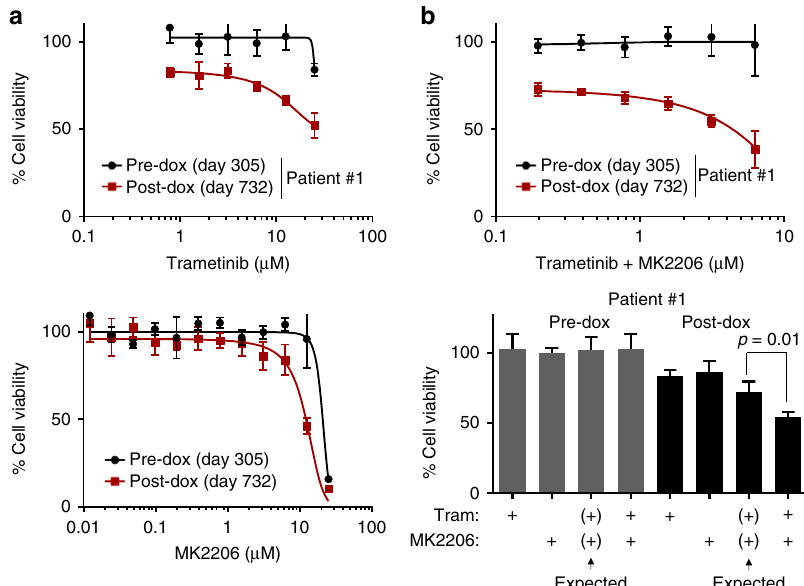
Fig. 7 Acquired sensitivity to drugs targeting post-chemotherapy phenotypes. a Drug response assay comparing pre- and post-doxorubicin patient #1 cancer cells ’ sensitivity to drugs after 3-day treatment ( fi broblast feeder system; CellTiter-Glo was used). b Indicated cells were treated with equimolar doses of trametinib and MK2206 for 3 days, followed by CellTiter-Glo (top); synergy analysis of 3.125 µ M doses of these drugs (bottom). Expected is by Bliss independence; P -value is by Student ’ s t -test (two-tailed). Fibroblast feeder system was used and fi broblast signal was subtracted out in a , b and percentages are relative to DMSO control mean. Error bars show s.d. of four technical